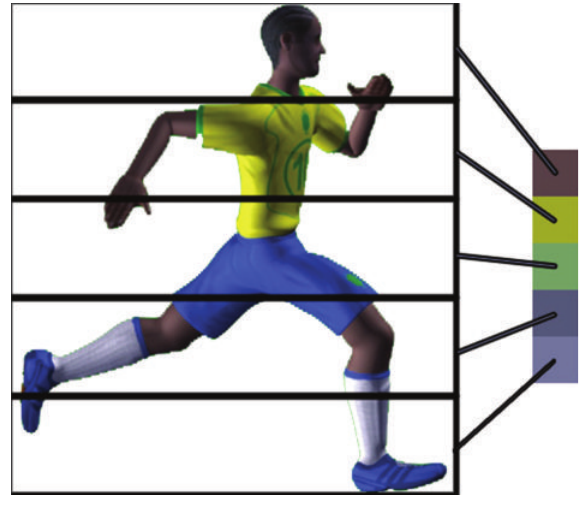
Figure 2: The appearance template of a tracked